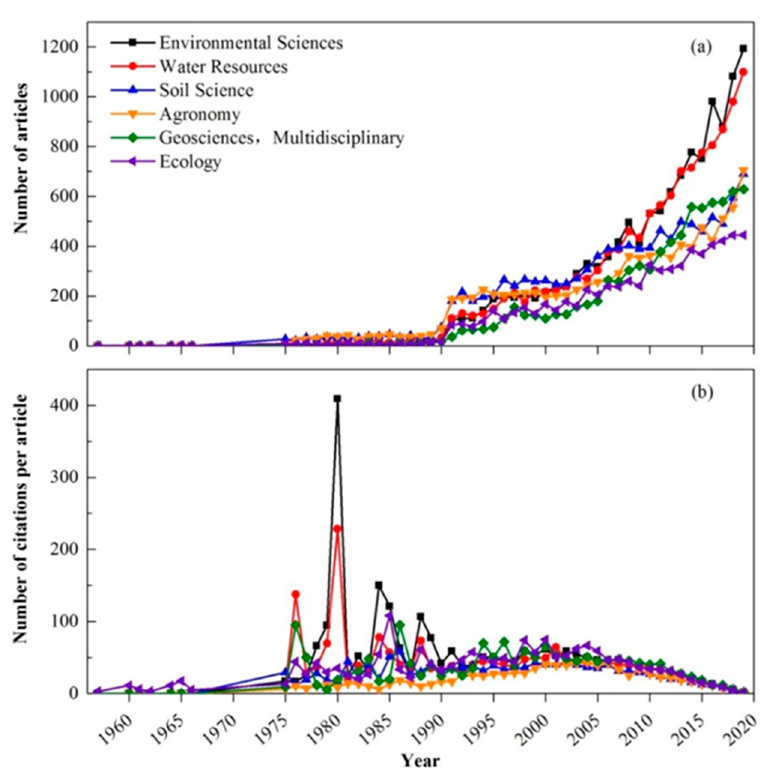
Figure 2. The annual number of soil water (SW) research articles ( a ) and citations per article ( b ) in the top 6 subject categories. Table 2. Top 20 productive journals in SW research during